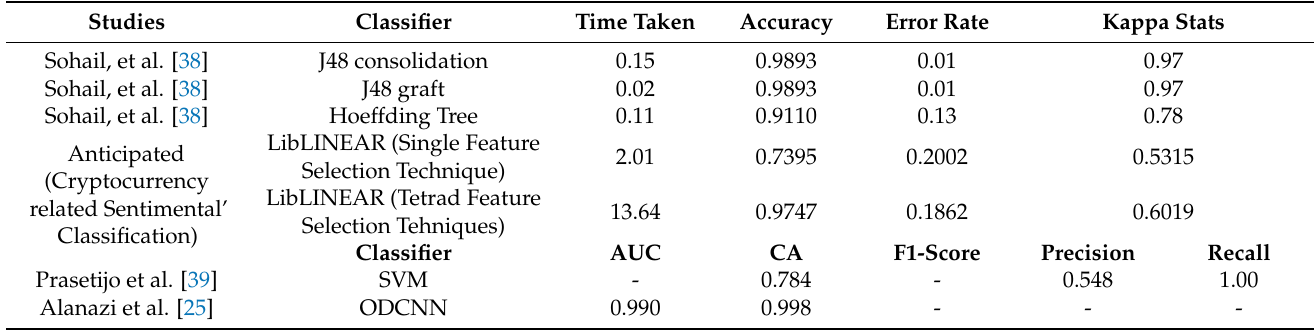
Table 13. Performance comparison of the anticipated text classification models with existing